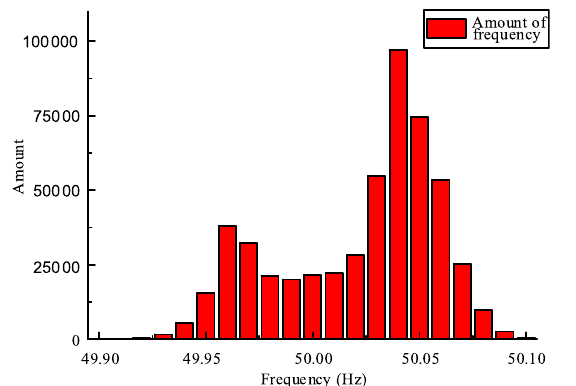
Fig. 7 The life degradation of the ESS under different SOC set-points and different frequency regulation dead